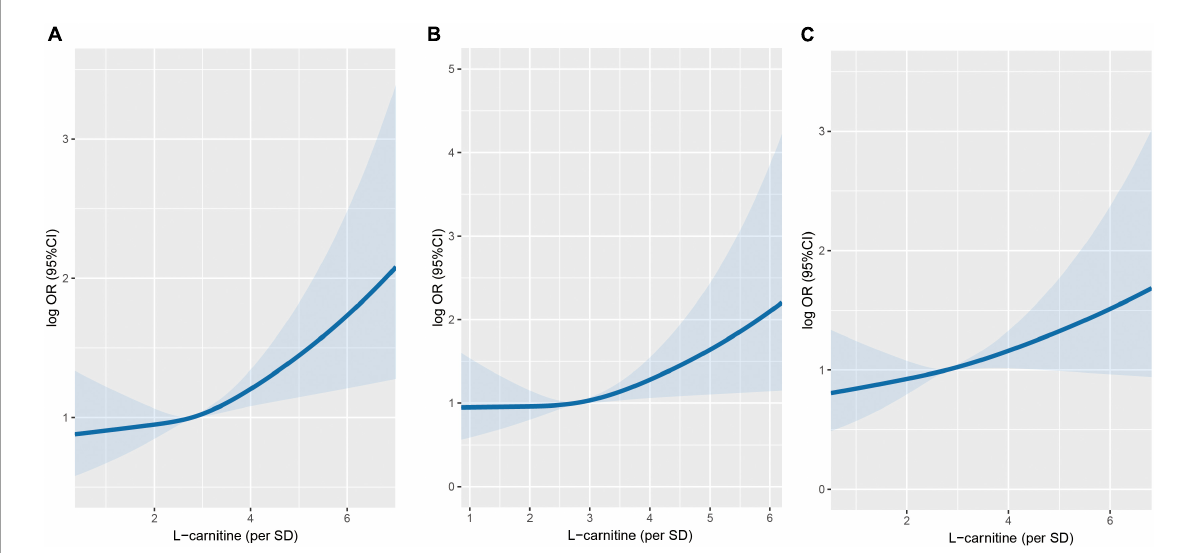
FIGURE2 Association between serum arginine concentrations and cancer risk using restricted cubic spline (RCS). (A) Overall cancer. (B) Digestive system cancer. (C) Non-digestive system cancer. Models were adjusted for BMI, smoking status, alcohol drinking, systolic blood pressure, triglycerides, cholesterol, uric acid, glucose, HDL-C, creatinine, ALB, ALT, HCY, sleep quality, antihypertensive drug usage, and family history of